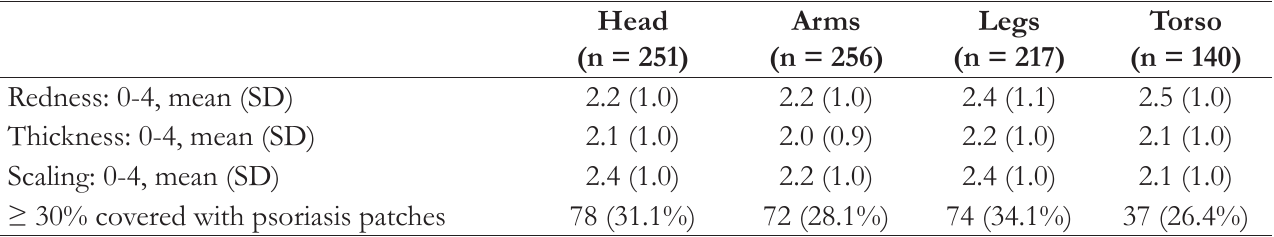
Table 3. Respondents’ Reported Psoriasis Severity, by Body Area (N = 392)